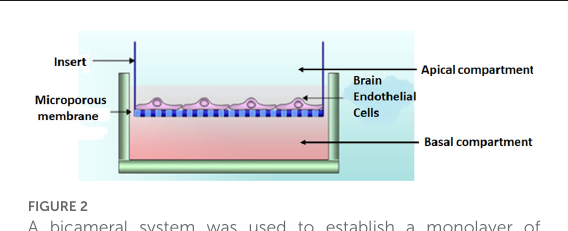
FIGURE2 A bicameral system was used to establish a monolayer of bEnd5 BECs which formed the central component of the in vitro BBB model we used in this study. Adapted from Xu et al.